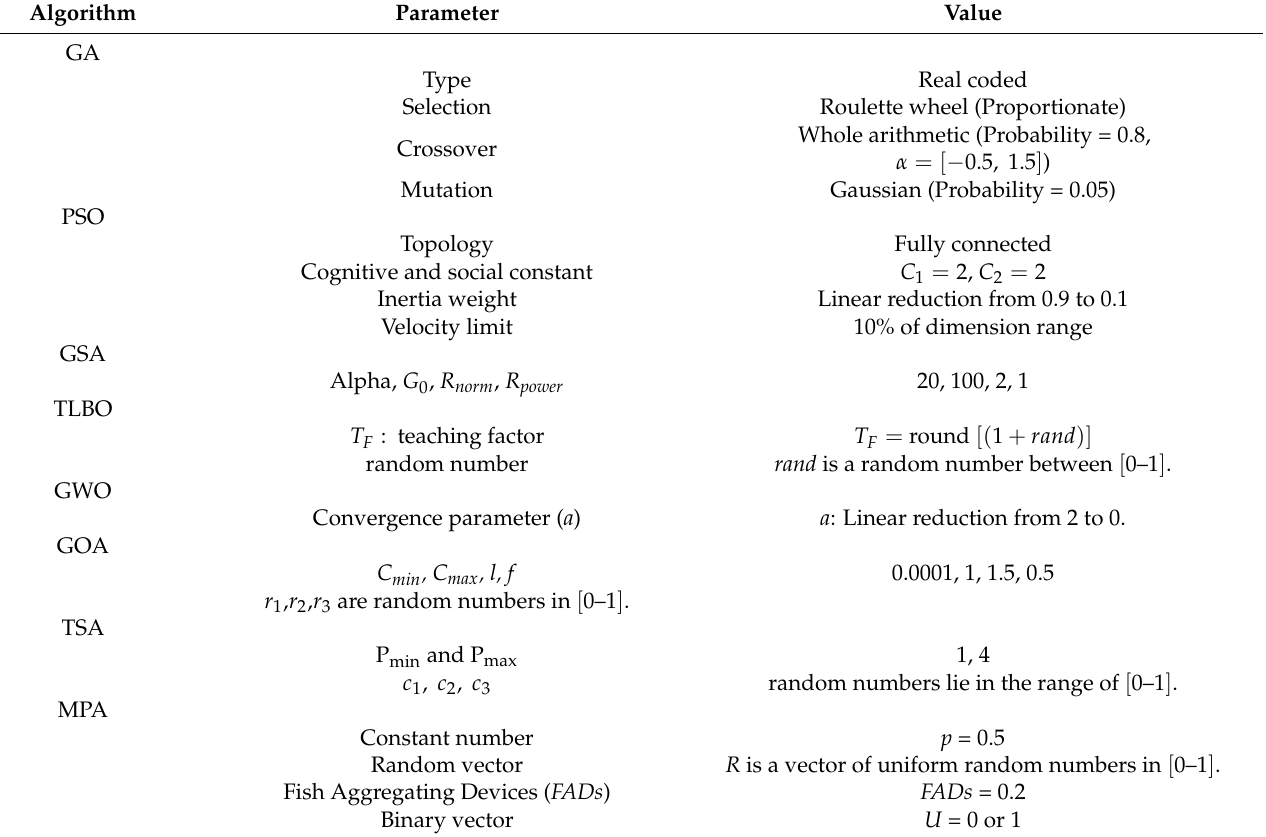
Table 1. Parameter values for the comparative